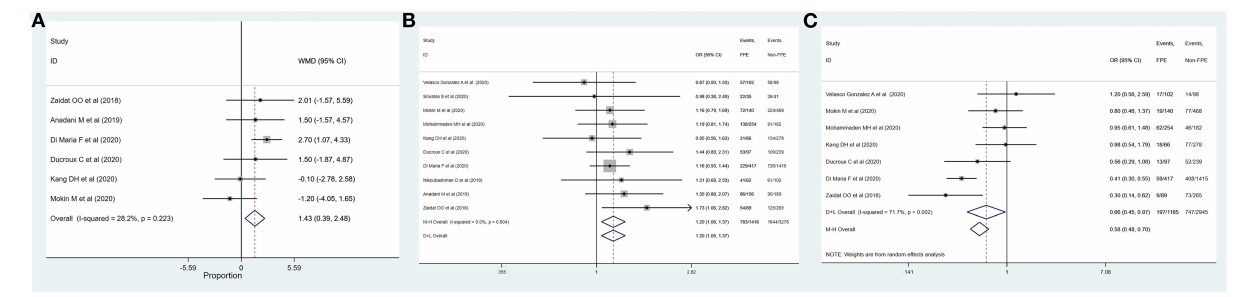
Frontiers in Neurology |